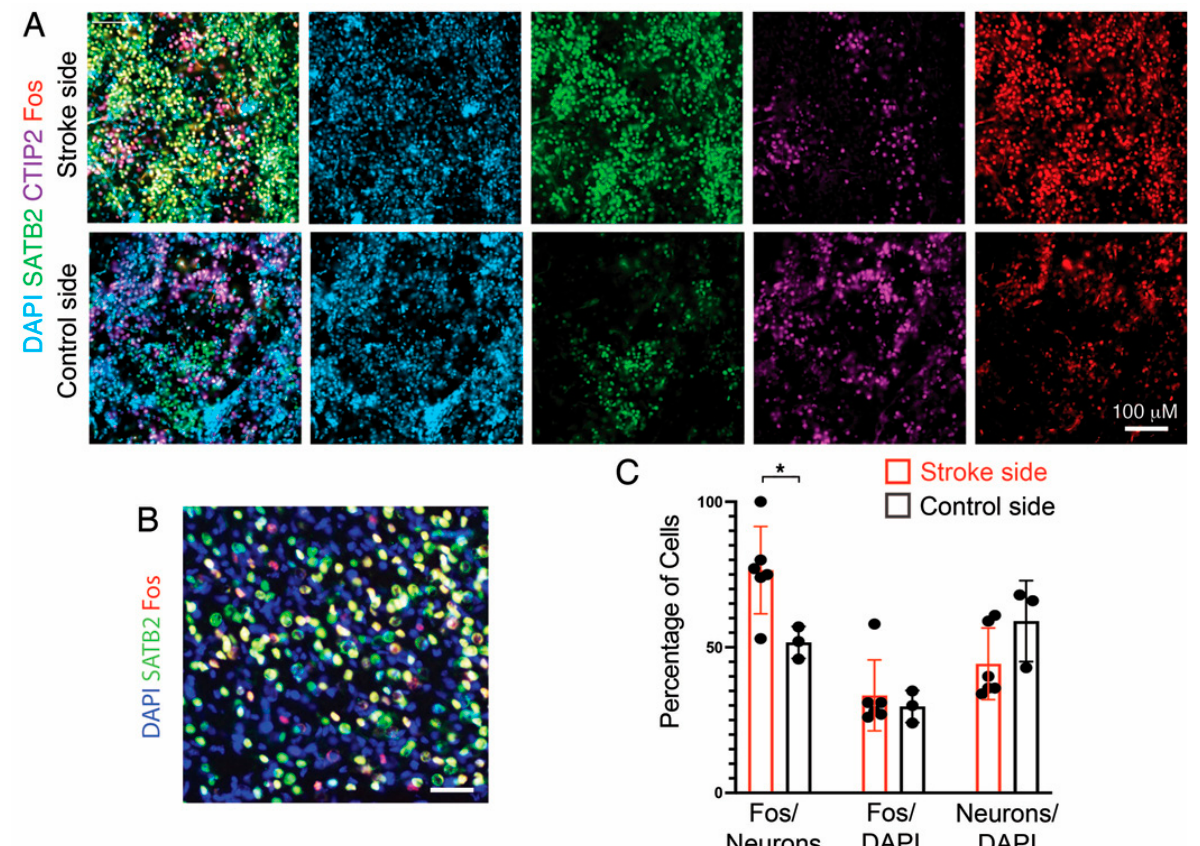
Figure 5. Analysis of Fos expression in grafts with and without stroke. ( A ) Representative immunofluorescent stains of grafts at stroke or control sites for SATB2 (green), CTIP2 (purple), and Fos (red). DAPI counterstain (blue). ( B ) Higher magnification view of staining of graft at a stroke site. Scale bar: 20 µM. ( C ) Quantitation of Fos+ cells. Each dot is the average from multiple sections of one mouse. Mann–Whitney test, * p < 0.05, +/ − s.t.d.